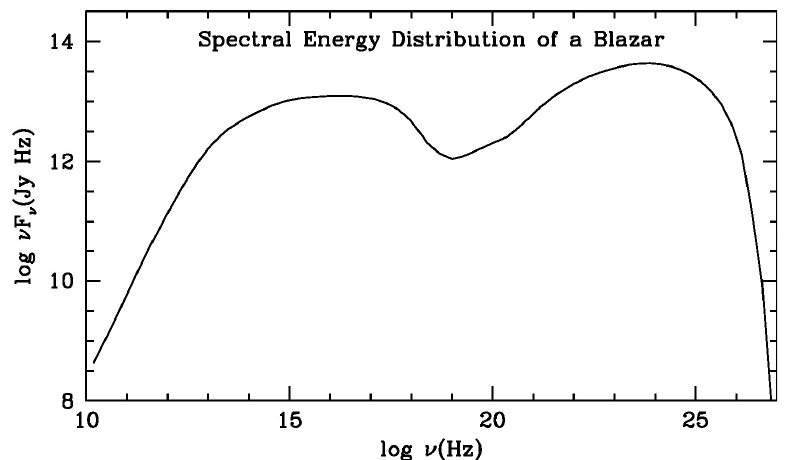
Figure 1. Sketch of the spectral energy distribution of a blazar. There are two peaks, one at low (infrared for low-synchrotron-peak blazars to X-ray for HSP BL Lac objects, the latter of which is shown here) and another at high ( γ -ray) photon energies.